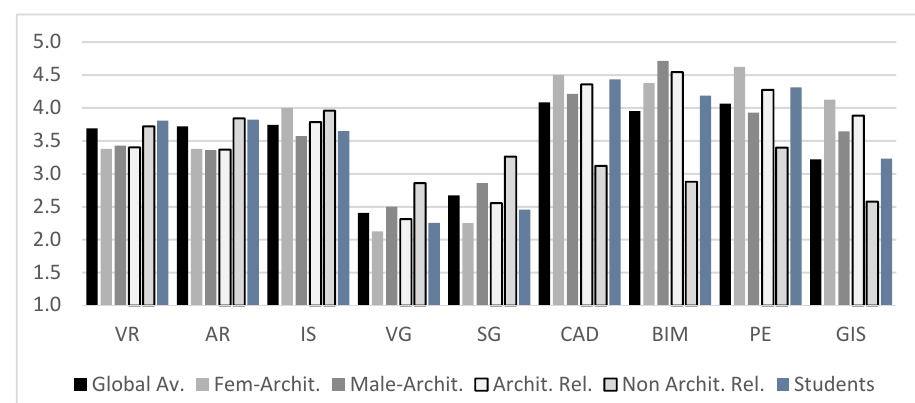
Figure 12. Level of importance of these technologies in current tasks.